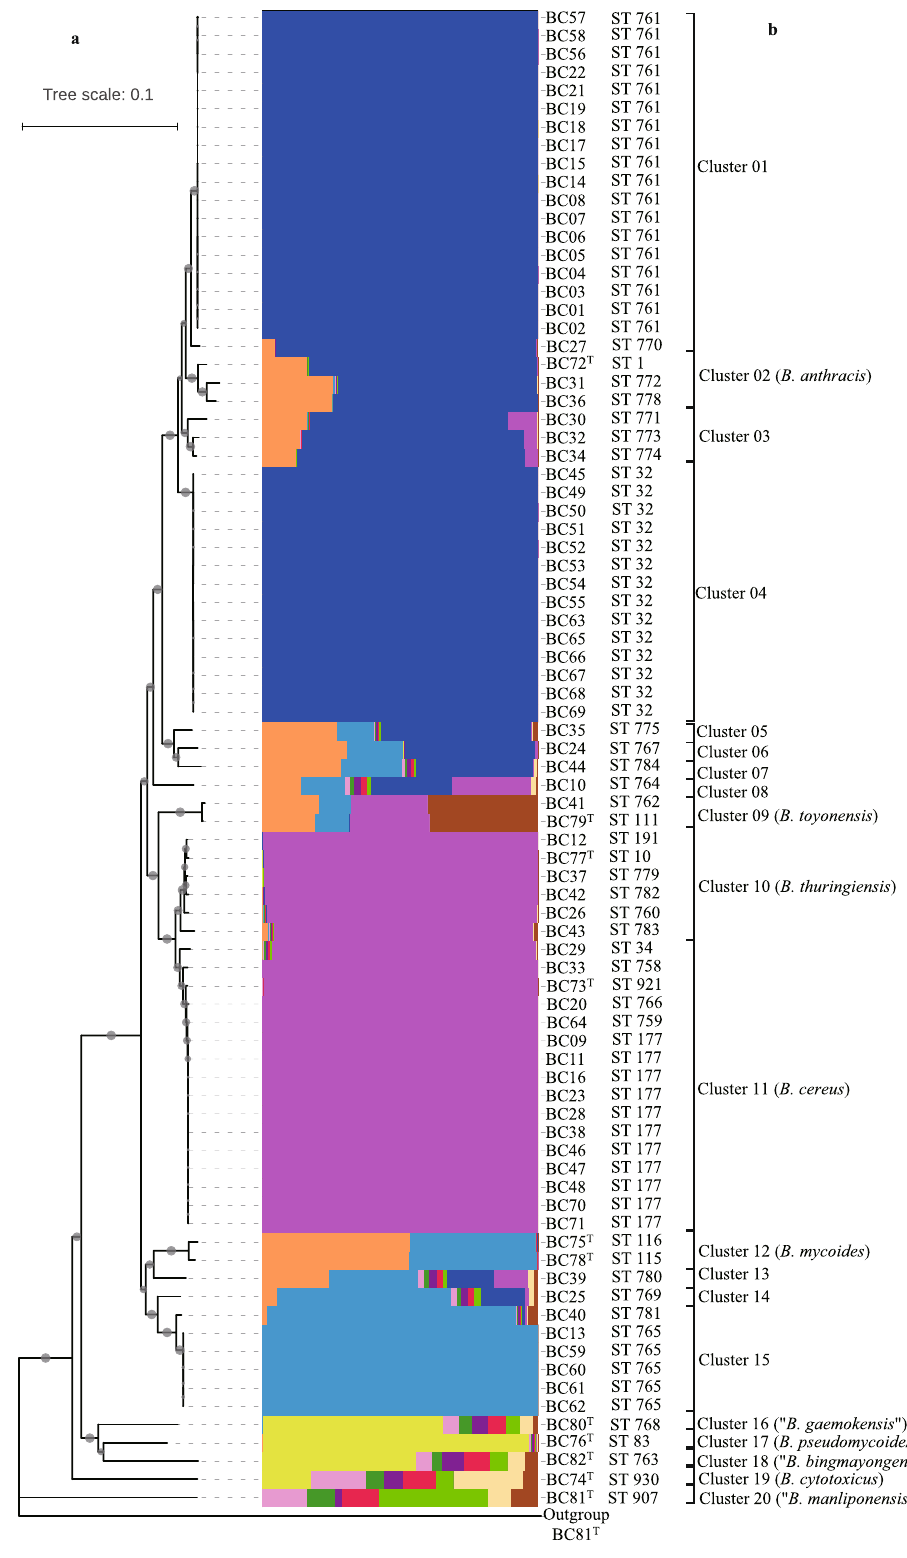
Figure 2. Diagrams denoting population structure and phylogeny of 82 bacteria of the B. cereus group. ( a ) The neighbor-joining phylogenetic tree of this group of strains was constructed on the basis of seven concatenated sequences using the software MEGA version 5.05. Bootstrap values (expressed by gray circles with different diameters) are shown at branch points. Bar, 0.1 nucleotide substitution rate ( K nuc ) units. Bacillus subtilis ATCC 6051 T was used as an outgroup. ( b ) Proportions of ancestral subpopulations of all strains and different colors representing distinct assumed subpopulations corresponding to Cluster 01 to Cluster